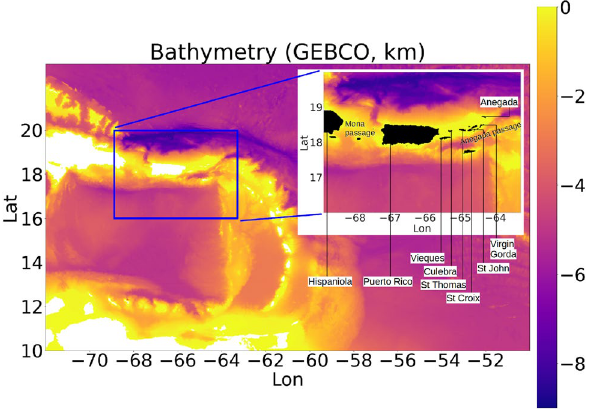
Figure 1. Map showing the Caribbean sea topography from the General Bathymetric Chart of the Oceans (GEBCO). Blue rectangle is the domain covered by USCROMS parent grid. The islands St Thomas, St Croix and St John form the US Virgin Islands (USVI). The islands Anegada and Virgin Gorda form the British Virgin Islands